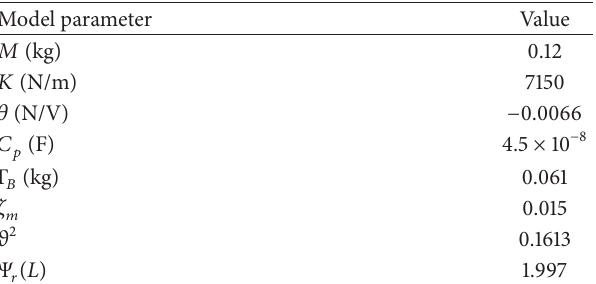
Table 2: Key parameters in the mathematical model. Model parameter